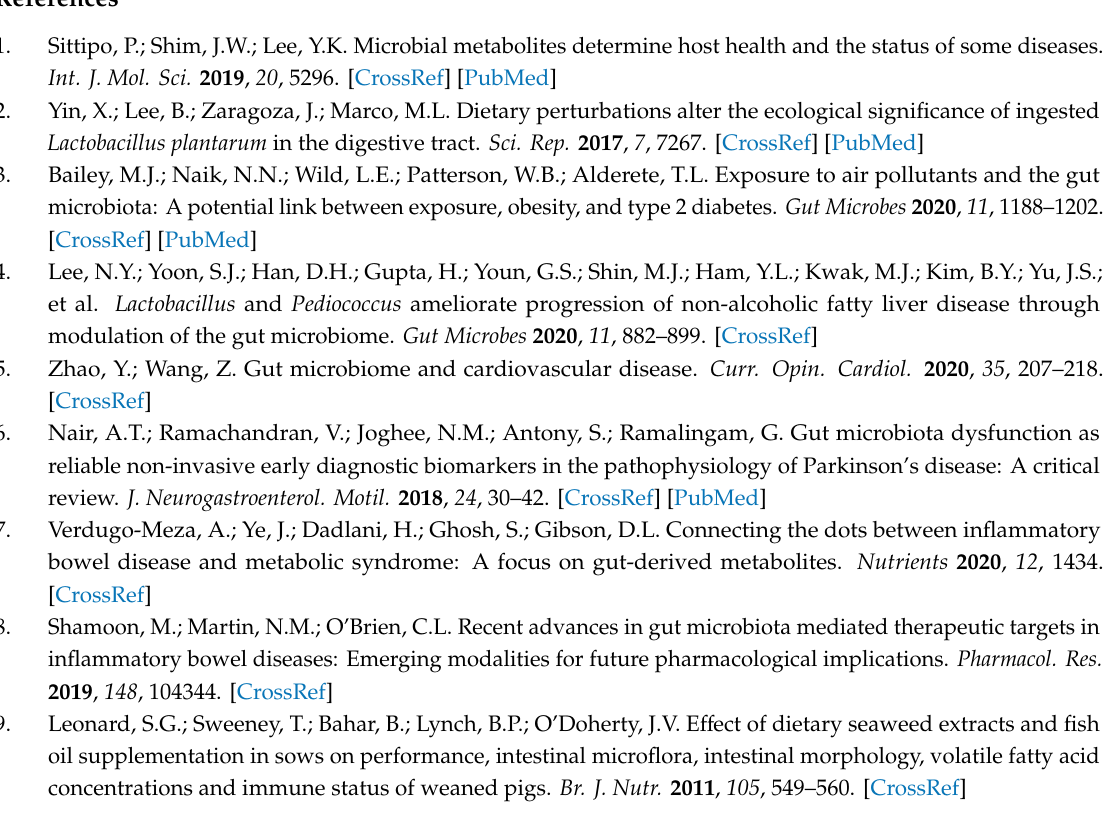
Figure S1: The sampling location of Porphyra tenera (Soan-do; 38 ◦ 8 (cid:48) 29.36” N, 126 ◦ 39 (cid:48) 22.59” E), Figure S2: Experiment design of animal experiment (A) and representative images of histological changes, Figure S3. Non-multidimensional scaling analysis showing gut microbiota di ff erence at Day 0 (A) and Day 7 (B). Ellipses in NMDS were drawn with a 0.95 confidence level using R vegan package. Di ff erentially abundant predicted metabolic pathways in CTL and NPTE groups (C). NPTE, PTE, DSS, and CTL indicate mice treated with PT extracts, mice treated with PT extracts and DSS, mice treated with DSS, and control mice not treated with PT extracts nor DSS, respectively. Figure S4: Significantly enriched and depleted KEGG orthologues (KO) in the butanoate metabolism, Table S1: The detail description of significantly enriched and depleted butanoate metabolic